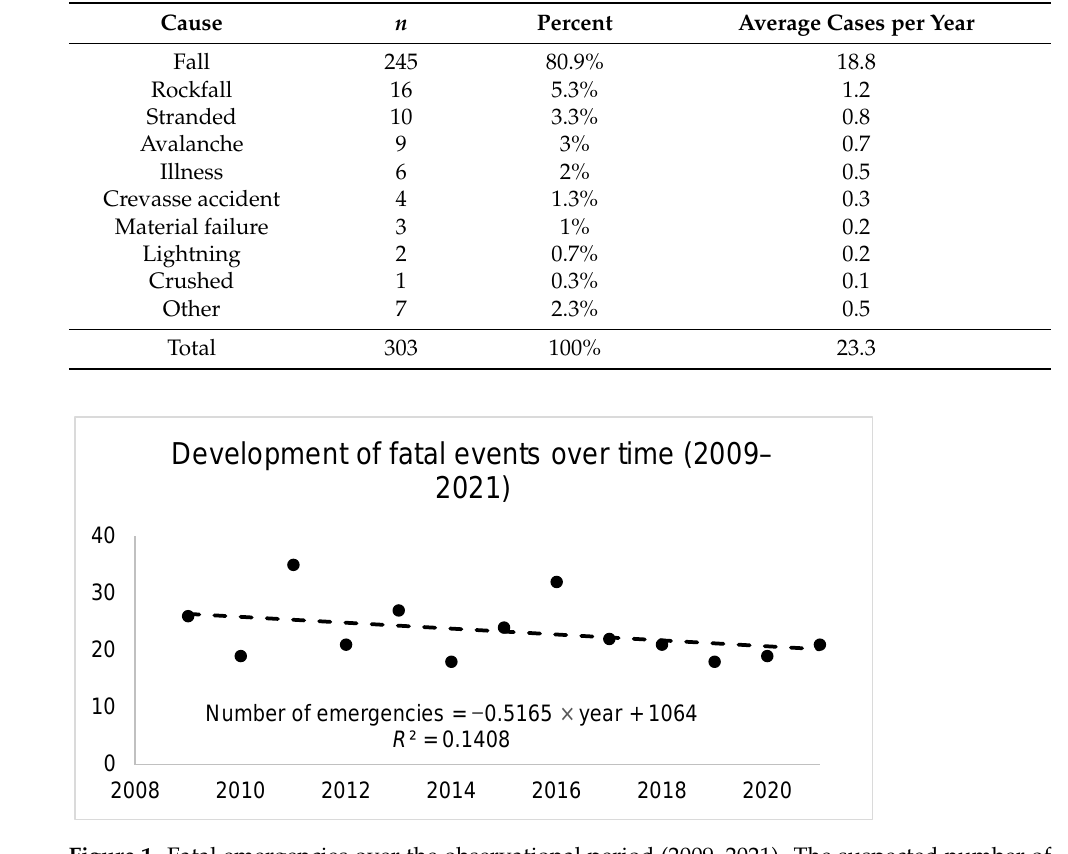
Figure 1. Fatal emergencies over the observational period (2009–2021). The suspected number of fatal events declined even more in relative terms. If one takes the SAC estimates of 150,000 alpinists in 2013 and of an increase of 4% per year, then there are around 225,000 alpinists per year now. A total of 172 cases were detected (56.8%) on classic four-thousanders. The most common peaks were the Matterhorn with 40 fatal cases (13.2%), the Mönch with 18